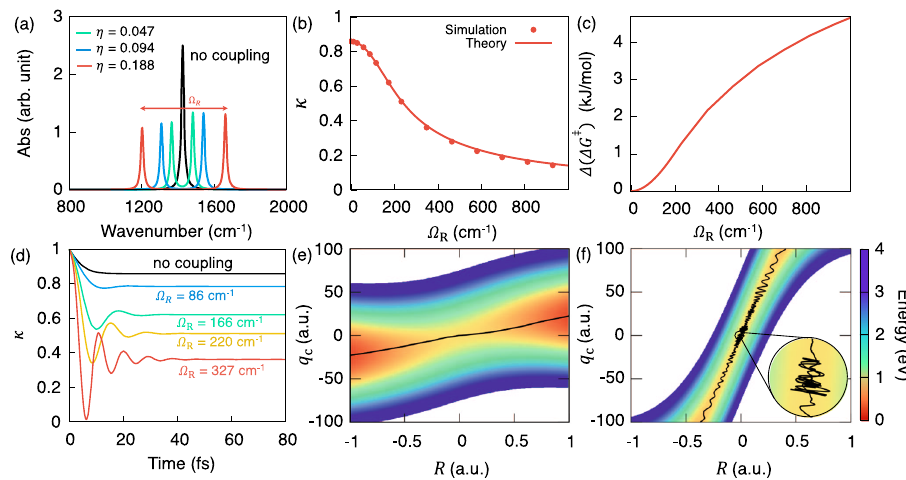
Fig. 2 Decrease in the rate constant as increasing light-matter couplings. a Infrared absorption spectrum by changing the normalized light-matter coupling strength η (see Eq (2)). b The transmission coef fi cient κ (under the limit t → t p ) under various light-matter coupling strength (indicated by Ω R ) at the resonant frequency ℏ ω c = ℏ ω 0 = 0.1706 eV. c The "effective change" of the Gibbs free energy barrier Δ ( Δ G ‡ ) with respect to the coupling strength Ω R at 300 K. d Time-dependent transmission coef fi cient κ ( t ) at various light-matter coupling strengths at the resonant frequency ℏ ω c = 0.1706 eV. e , f Cavity Born – Oppenheimer surfaces ^ V CBO ð R ; q c Þ at η = 0.047 and η = 0.376, respectively, with representative reactive trajectories indicated with black solid